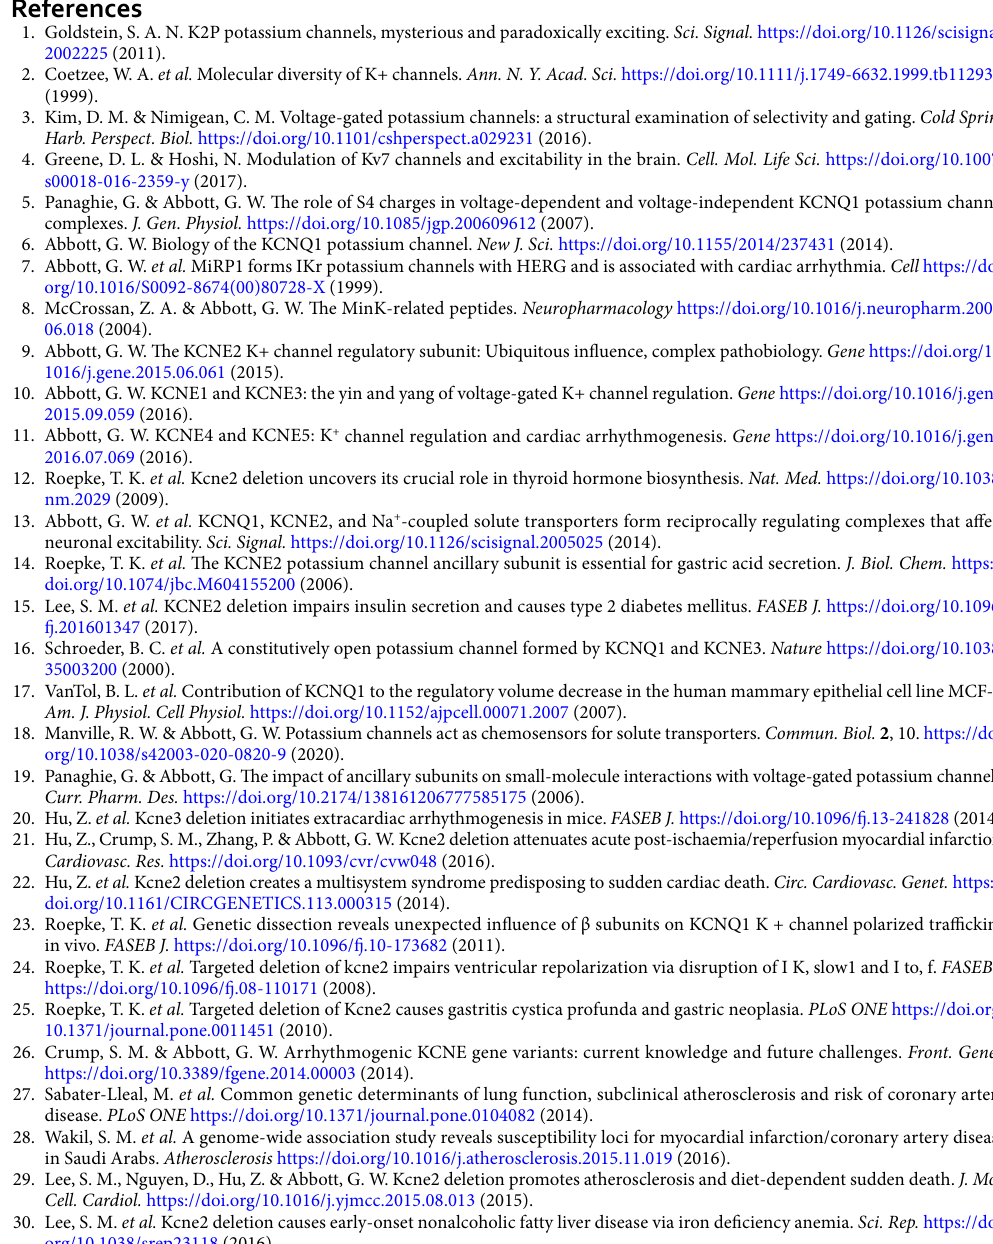
FFS. Distributions are represented with violin plots using the MATLAB function “Hoffmann H, 2015: violin.m—Simple violin plot using MATLAB default kernel density estimation. INRES (University of Bonn), Katzenburgweg 5, 53,115 Germany.“ Bandwidth was set as 0.0033 (Fig. 3C), 53.33 (Fig. 3D), 0.0005 (Fig. 3E) and 1.5 (Fig. 5A). Tukey’s test was used for multiple comparisons statistics by using the MATLAB function “multcompare” with statistics provided by the “anova1” function, which computes the one-way ANOVA (anal- ysis of variance). Statistical significance is shown as asterisks corresponding to P -values < 0.05 (*), < 0.01 (**) and < 0.001 (***). All distributions have been tested for normality by a single sample Kolmogorov–Smirnov test, yielding high confidence results for all distributions ( P > 0.91). Complete diagrams of statistical significance are shown in the Supplementary